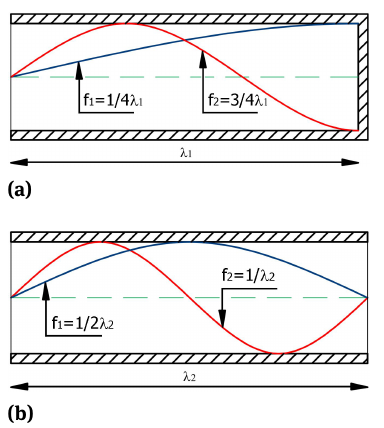
Figure 1: Distribution of standing wave in the waveguide for the first f 1 and second f 2 resonant frequency a) closed end tube, b) open tube